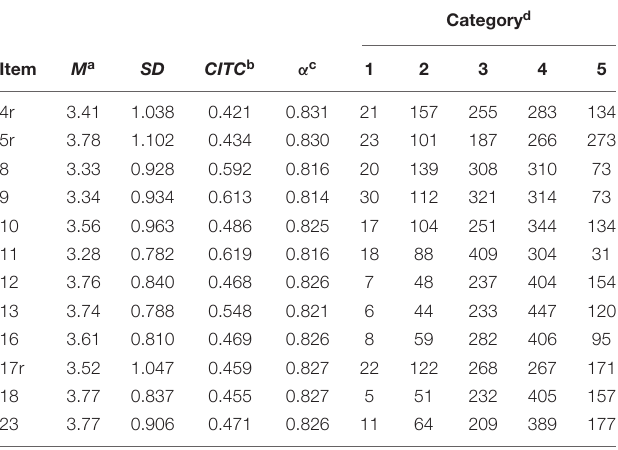
TABLE 4 | Classical item analysis of the intentionality scale ( α = 0.76, CI 95 = 0.73, 0.78).